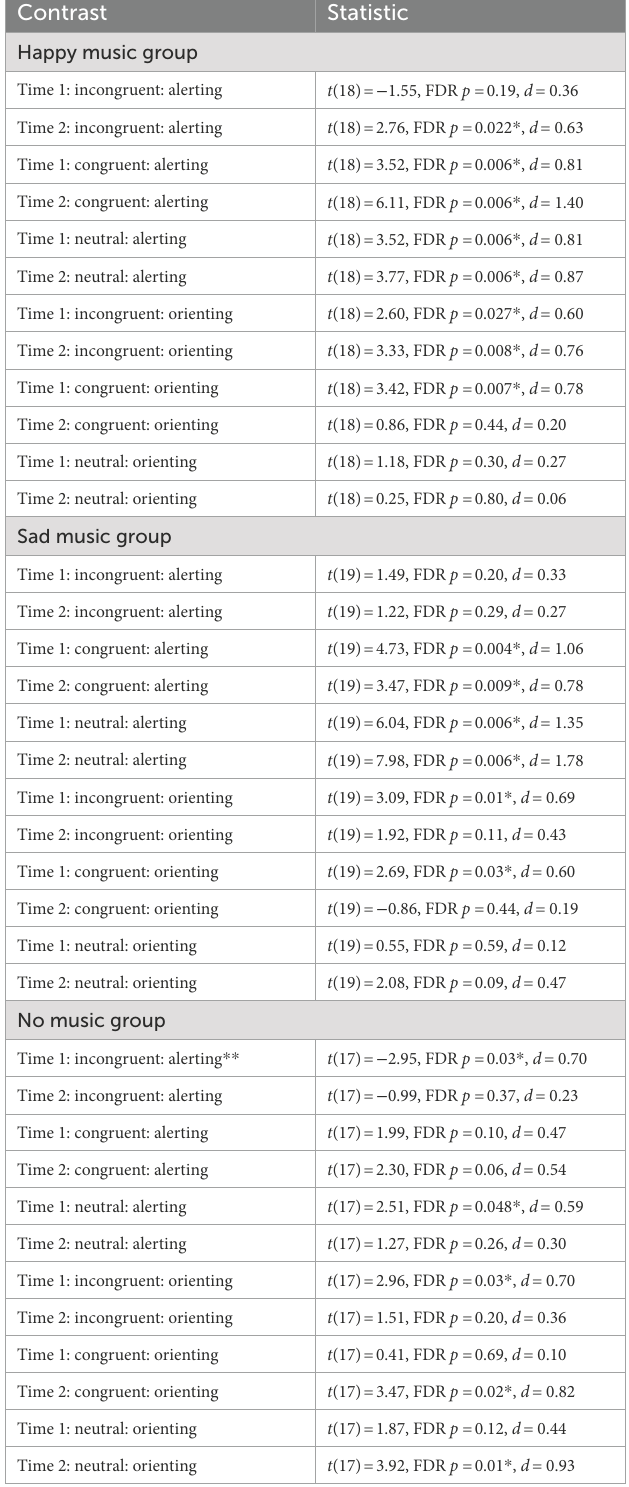
TABLE 4 The full mixed ANOVA model results for reaction time across both ANT time points. Effect, interaction, or Statistic contrast